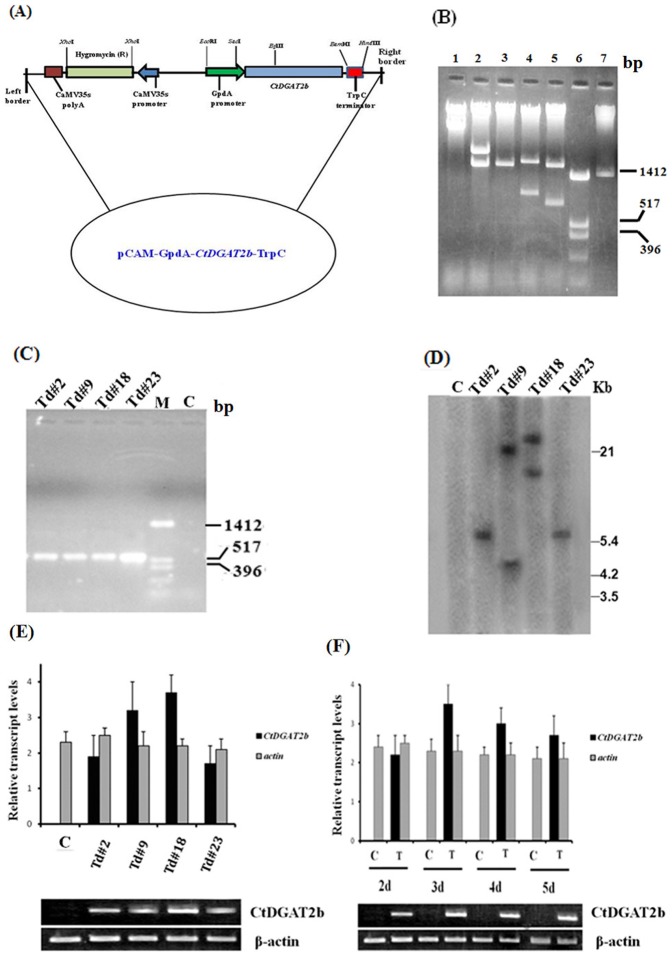
Development of Colletotrichum transformants with the CtDGAT2b gene expression construct, pCAM-GpdA-CtDGAT2b-TrpC through Agrobacterium-mediated transformation.(A) Schematic diagram of the genetic construct prepared in pCAMBIA 1300 binary vector. (B) Ethidium bromide-stained 1.2% agarose gel showing characteristic restriction enzyme digestion profile of the genetic construct with EcoRI+HindIII (lane1), EcoRI+BamHI (lane2), BamHI (lane3), SalI+BglII (lane 4), BamHI+HindIII (lane 5) and XhoHI (lane 7) along with the pUC18 DNA digested with Hinf1 as molecular weight marker (lane 6). (C) PCR-based screening for the presence of 550 bp CtDGAT2b transgene-specific amplicon in four (Td#2, Td#9, Td#18 and Td#23) chosen transformed lines. Lane M =  HinfI digested pUC18 DNA as molecular weight marker. (D) Confirming genomic integration of the CtDGAT2b transgene through Southern hybridization. Genomic DNA samples of four transformed lines were digested with EcoR1, and hybridized with the CtDGAT2b gene-specific probe. Lambda (λ) DNA digested with EcoRI+HindIII was used as molecular weight marker. In case of (C) and (D), the wild type Colletotrichum sp. DM06 was taken as control (lane C). (E) Transcriptional expression of the CtDGAT2b transgene in four fungal transformants as revealed by RT-PCR for 26 cycles. (F) Transcriptional expression of the CtDGAT2b in one of the fungal transformants, Td#18 (T) as revealed by RT-PCR for 26 cycles, showing upregulation of CtDGAT2b transcript upto 3rd day of growth and declined at 4th day onward. In case of (E) and (F), the wild type Colletotrichum sp. DM06 was taken as control (C), and the relative transcript level was measured based upon the densitometric scanning of the RT-PCR amplicons (550 bp for CtDGAT2b and 400 bp for endogenous β-actin as internal control) as shown in lower panel.